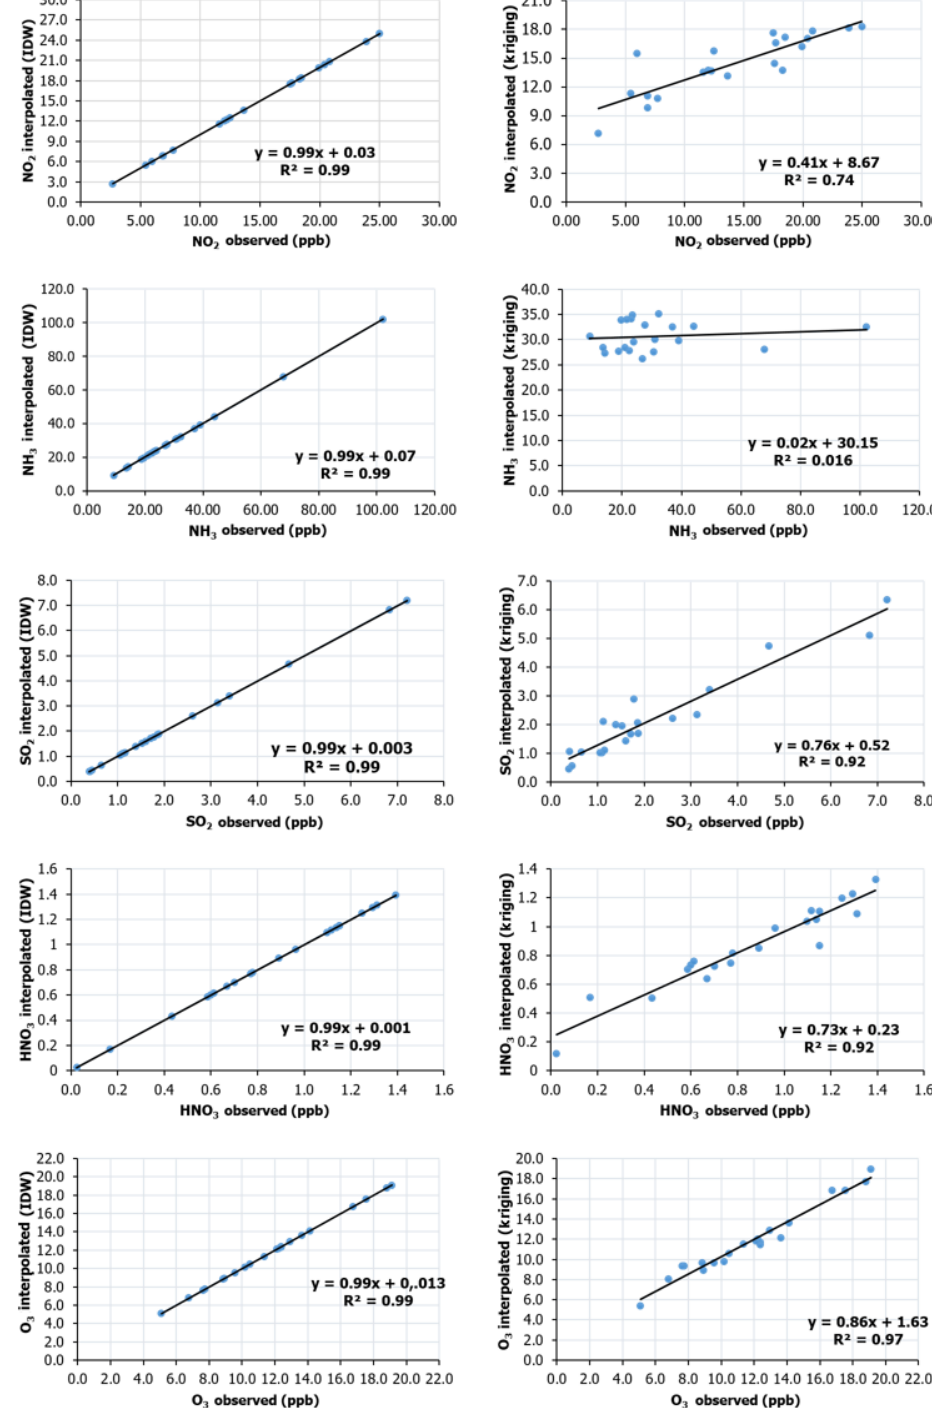
Figure 6. Regression between interpolated data and observed data using IDW and the kriging